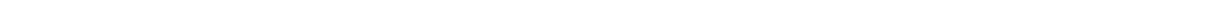
Figure 6 | Neuronal activity promotes Act b expression which drives hemocyte expansion. ( a – d ) Carbachol induces dose-dependent transcriptional induction of an Act b reporter. ( a ) Quantification of luciferase expression in larval fillets of Act b -GAL4, UAS-CD4-tdGFP/UAS-luciferase animals, stimulated by increasing doses of carbachol as intact larvae (2.5mgml (cid:2) 1 ; 10mgml (cid:2) 1 ). Pools of 2-3 larval fillets per sample in biological replicates; carbachol- stimulated conditions were normalized to unstimulated condition (total n ¼ 4–6 per condition); statistics show average of four such